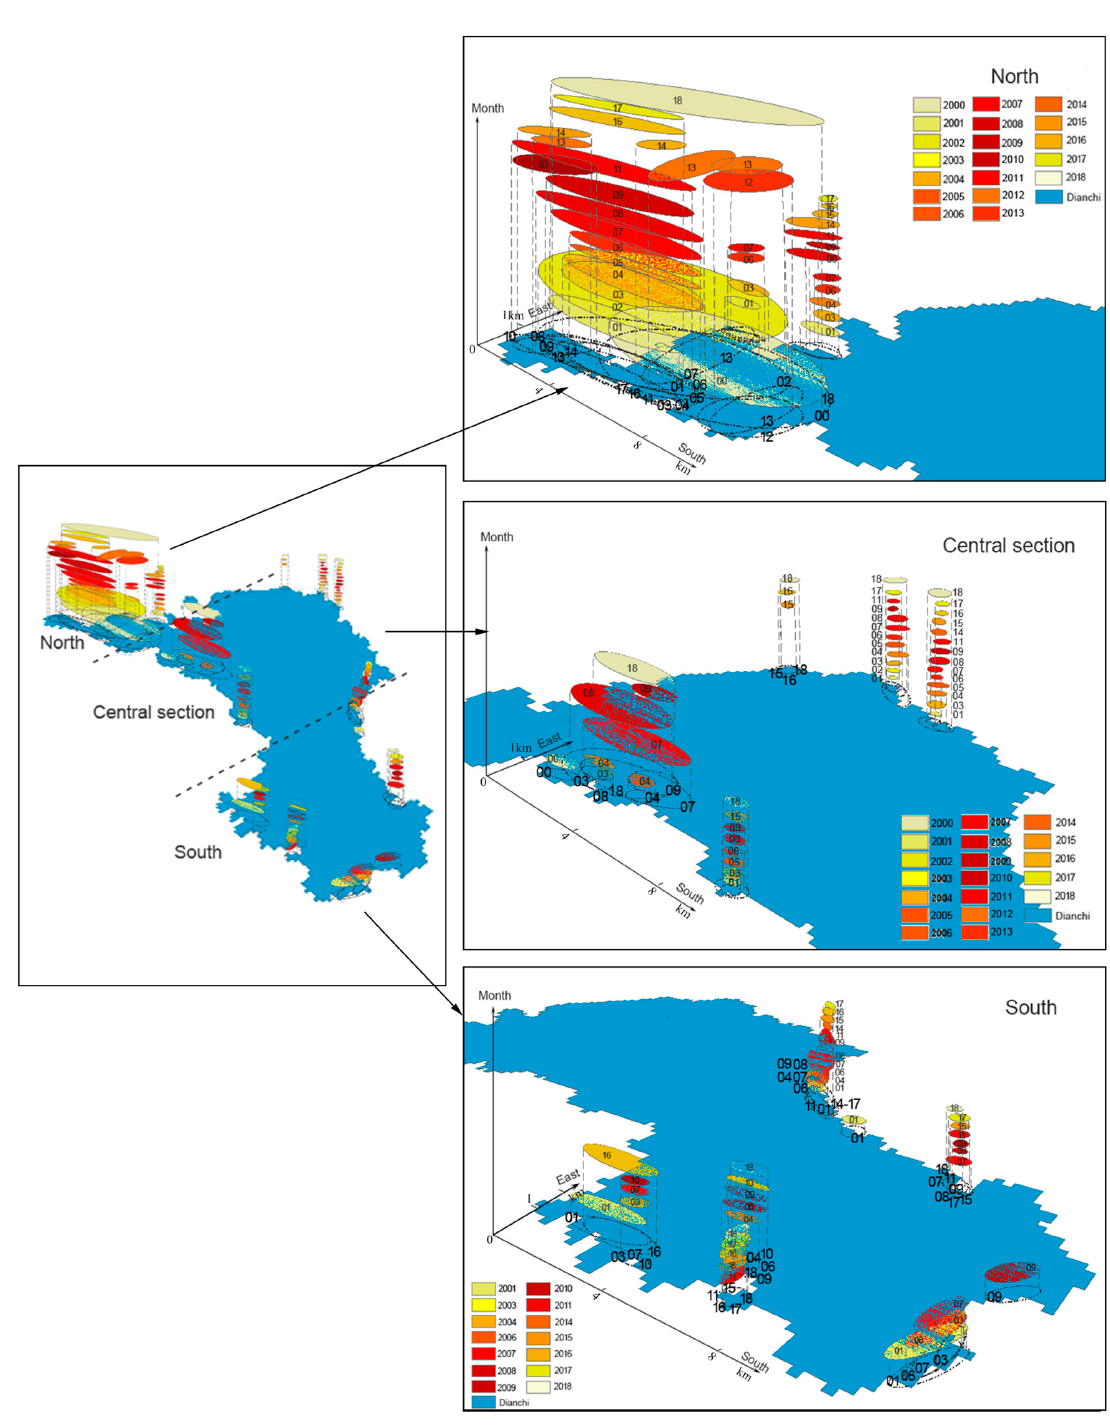
Figure 12. Variation in the spatiotemporal trajectory of the annual ABF in Lake Dianchi during 2000–2018. Numbers 00–18 are shorthand terms for 2000–2018.